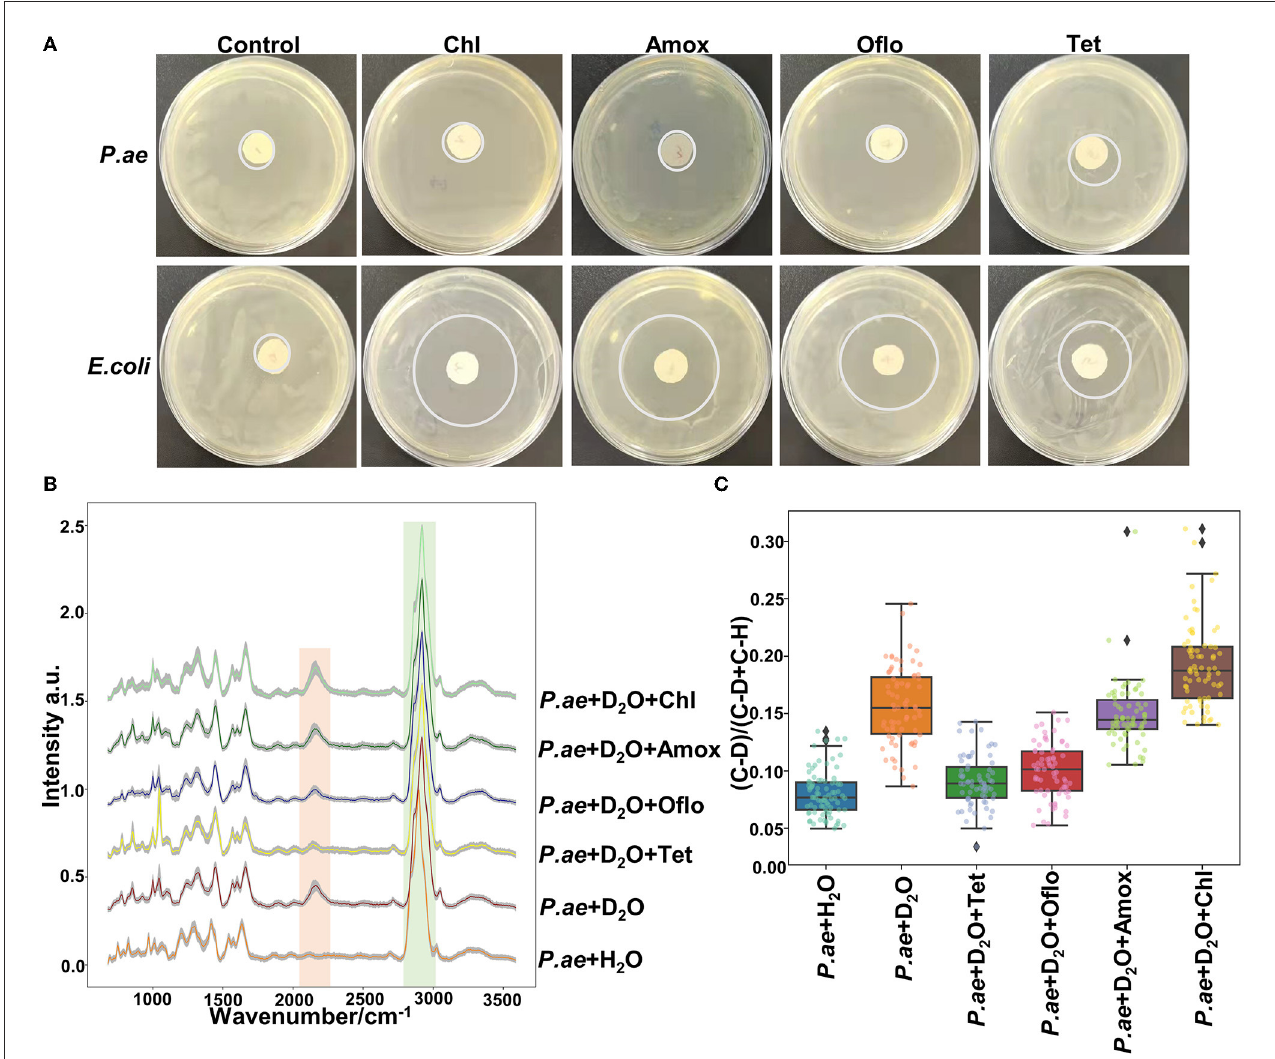
FIGURE5 Resistance of Pseudomonas aeruginosa to different antibiotics. (A) Representative images of Pseudomonas aeruginosa and E. coli in different antibiotics. (B) Spectra of Pseudomonas aeruginosa in different antibiotics. (C) C–D ratio analyzed by heavy water labeling. The C–D peak was located at 2,040–2,300 cm − 1 and the C–H peak at 2,800–3,100 cm − 1 . According to C–D/(C–D + C–H), the activity of drug-resistant bacteria was determined. The antibiotics used were cefazolin, amoxicillin, tetracycline, and